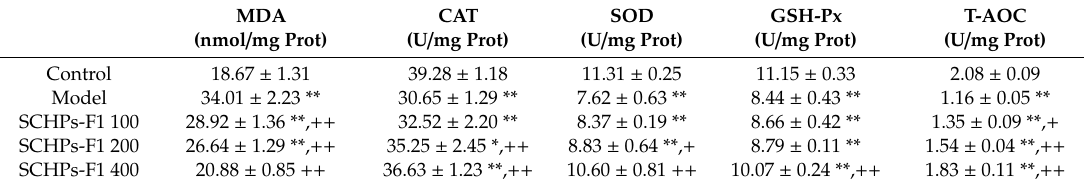
Table 1. The e ff ects of SCHPs-F1 on MDA, CAT, SOD, GSH-Px, and T-AOC levels in renal homogenates o CTX-induced mice.